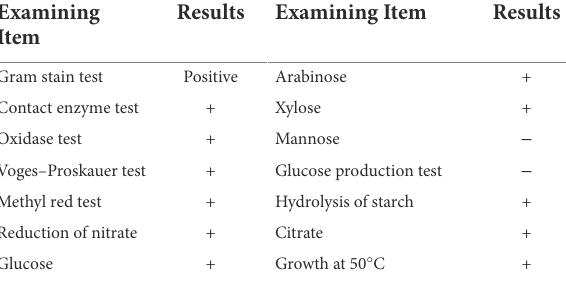
TABLE 3 Detection of physiological and biochemical parameters of the FYN-22 strain. ‘+’ denotes presence of the ability; ‘ − ’ denotes absence of the